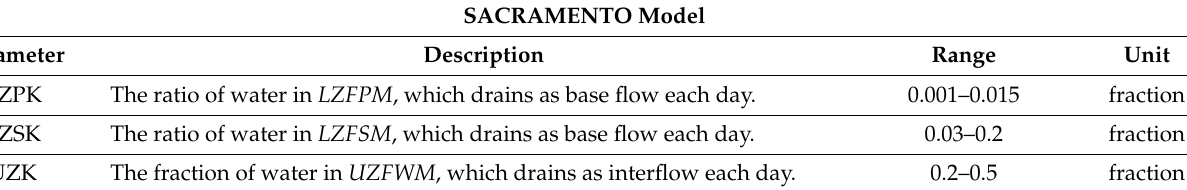
Table 3. Parameters of SACRAMENTO model and their